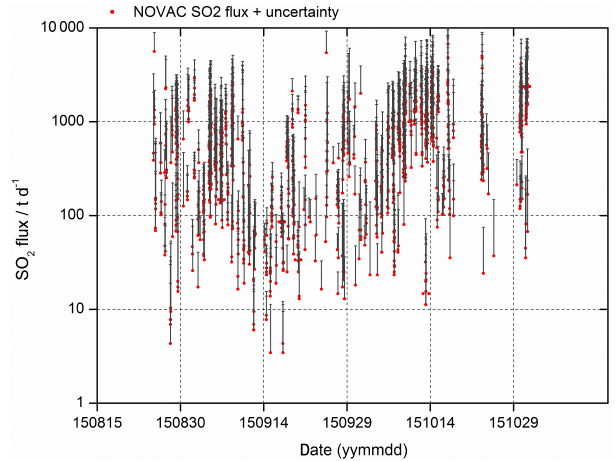
Figure 7. SO 2 emission (td − 1 ) from individual scan measurements of the DOAS network (red) during the large August–October 2015 eruption. The uncertainty comes from the spectroscopic retrieval, radiative transfer, wind direction and speed and plume height. This uncertainty is used in the computation of the daily mean values as presented in Fig. 6.